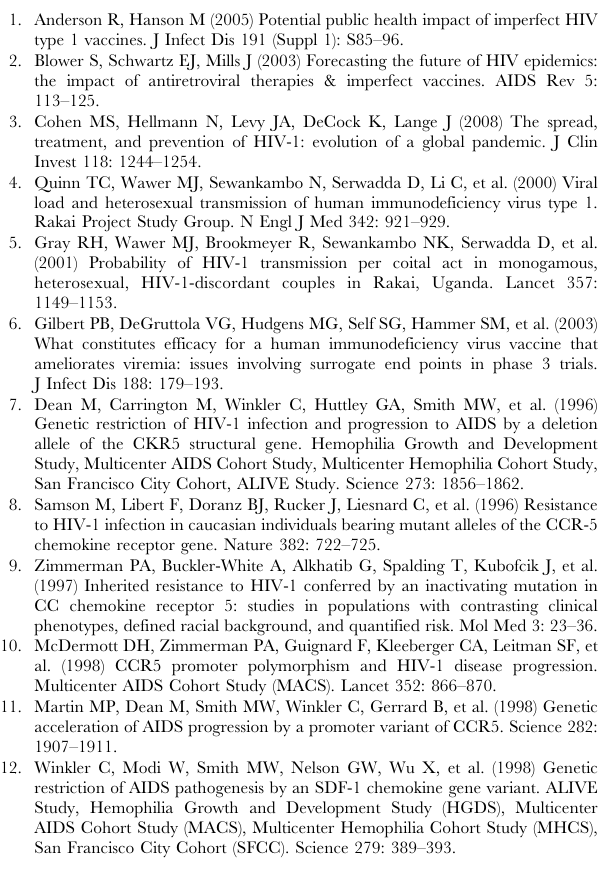
Table S1 Summary of parameters used to model the influence of CCL3L1-CCR5 GRGs on epidemiological endpoints. Note, the inclusion of the parameters of vaccine efficacy and durability were included on a proof-of-principle basis for vaccines which rely in part on CMI for their effects.